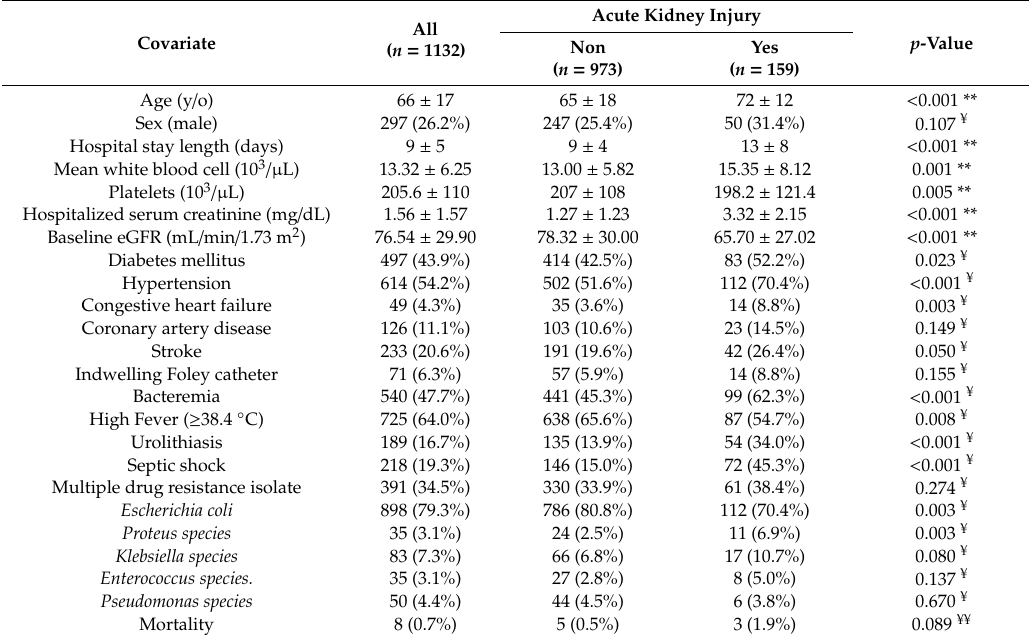
Table 2. Characteristics of hospitalized patients with urinary tract infection with respect to acute kidney injury. All Covariate ( n = 1132)